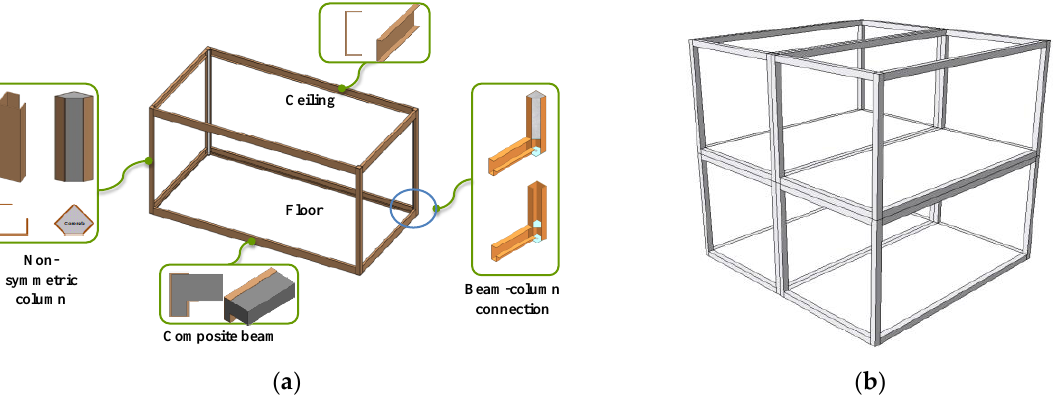
Figure 1. The proposed composite modular unit structure: ( a ) components; ( b ) assembly of units.